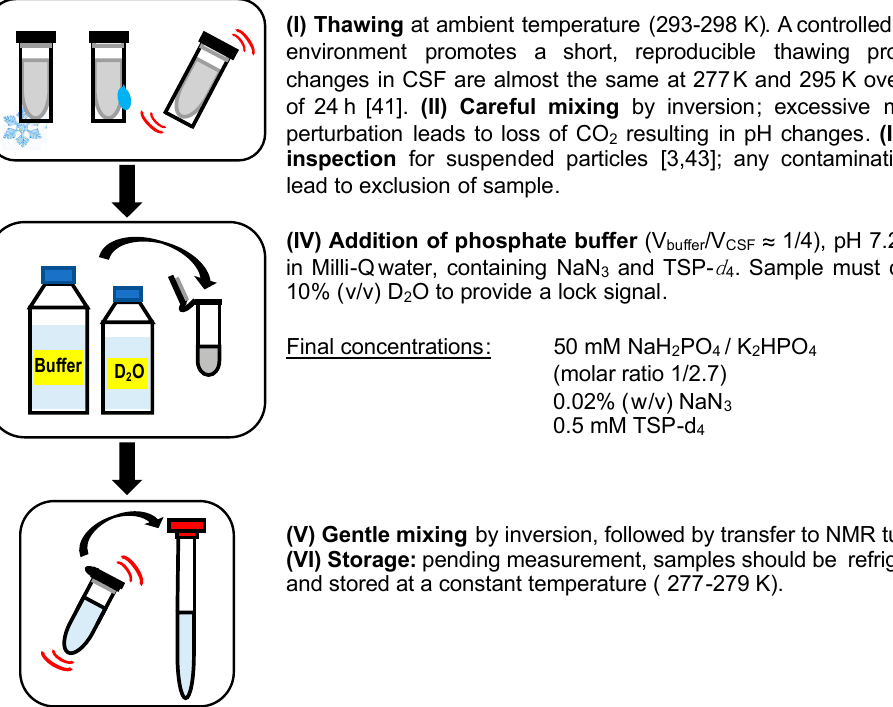
Figure 2. Proposed CSF sample preparation workflow detailing key aspects of sample handling and pH control (buffer composition described in step IV).